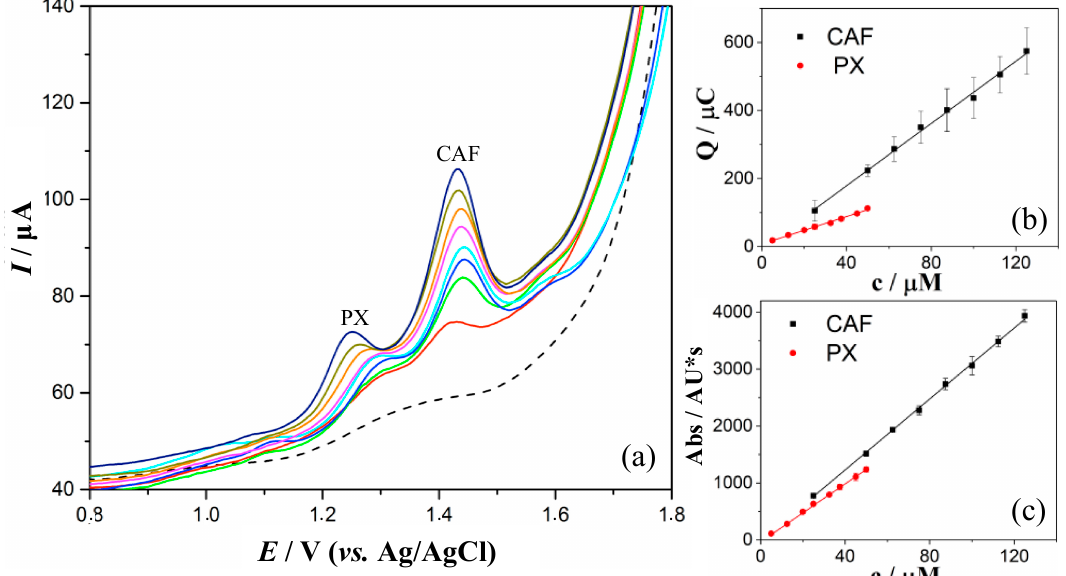
Figure 5. ( a ) DP voltammograms of paraxanthine (PX, E PX = +1.25 V) and caffeine (CAF, E CAF = +1.45 V) extracted from spiked saliva on the GC electrode at a scan rate of 5 mV s − 1 ; PX and CAF concentrations assuming quantitative extraction: blank saliva (black dashed line), 25 µ M and 5 µ M (red), 50 µ M and 12.5 µ M (green), 62.5 µ M and 20 µ M (blue), 75 µ M and 25 µ M (light blue), 87.5 µ M and 32.5 µ M (pink), 100 µ M and 37.5 µ M (yellow), 112.5 µ M and 45 µ M (dark yellow), 125 µ M and 50 µ M (blue); corresponding calibration curves by ( b ) DPV and ( c )